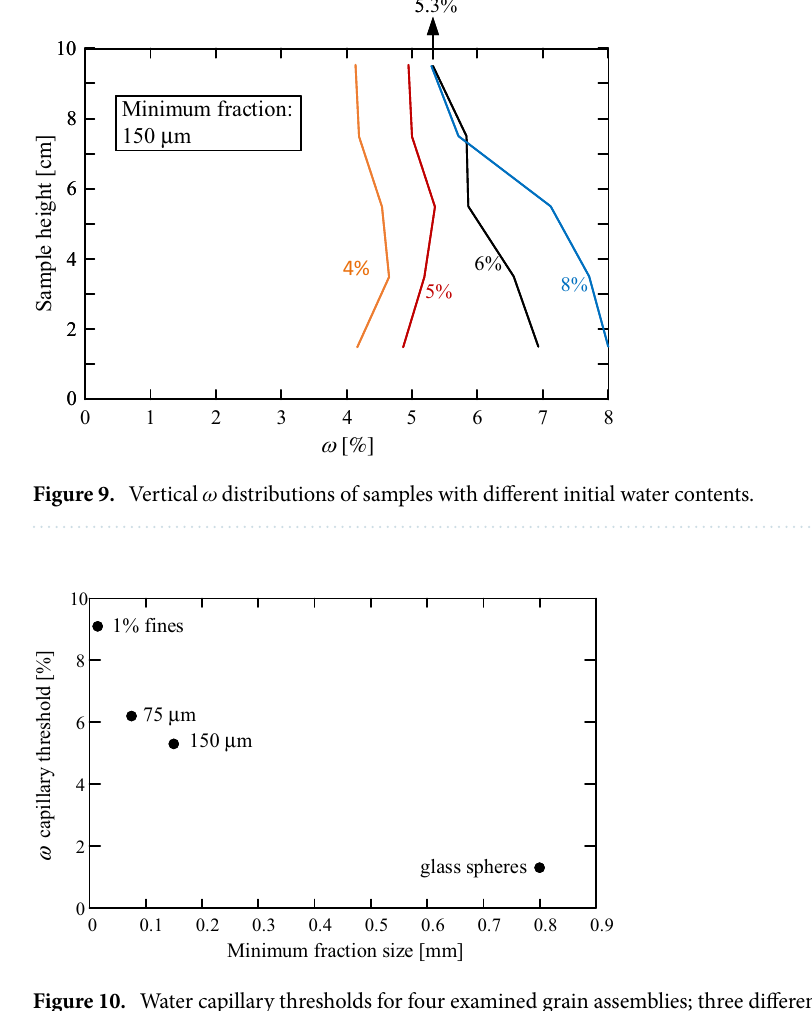
Figure 10. Water capillary thresholds for four examined grain assemblies; three different grading of the same soil and a glass spheres